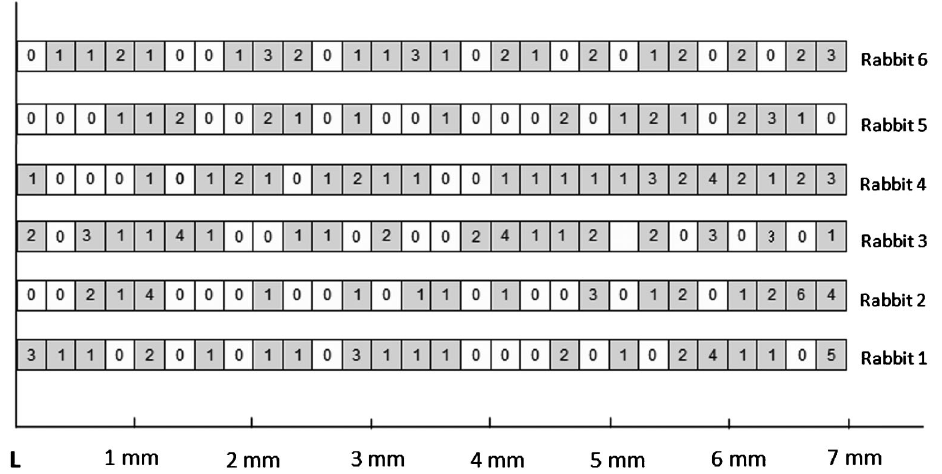
Figure 1. Diagram showing the crude distribution of the labeled nuclei in paraffin sections of the corneal epithelium of 6 animals killed 8 h after the intravitreal injection of [ 3 H]-TdR. The measurements started at the limbus (L) and finished at the corneal center. The boxes represent 250- m m long segments and the numbers inside them the labeled nuclei; white boxes are segments with no labeling. The farther from limbus the higher the probability of observing labeled nuclei (P = 0.0035; Pearson r = 0.532).